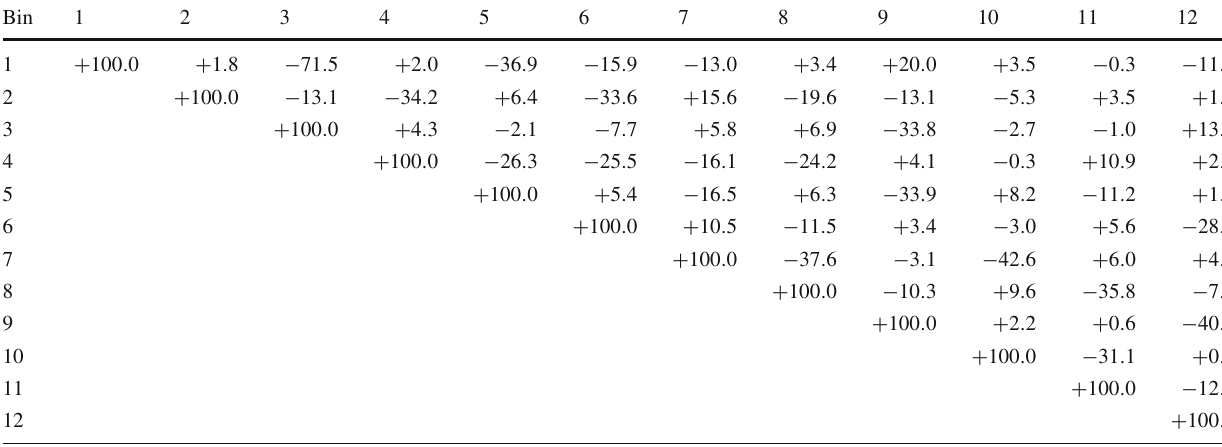
Table 15 The correlation matrix of statistical uncertainties for the normalized tt double-differential cross sections as a function of M ( tt ) and Δη( t , t ) . The values are expressed as percentages. For bin indices see Table 14 Bin 3